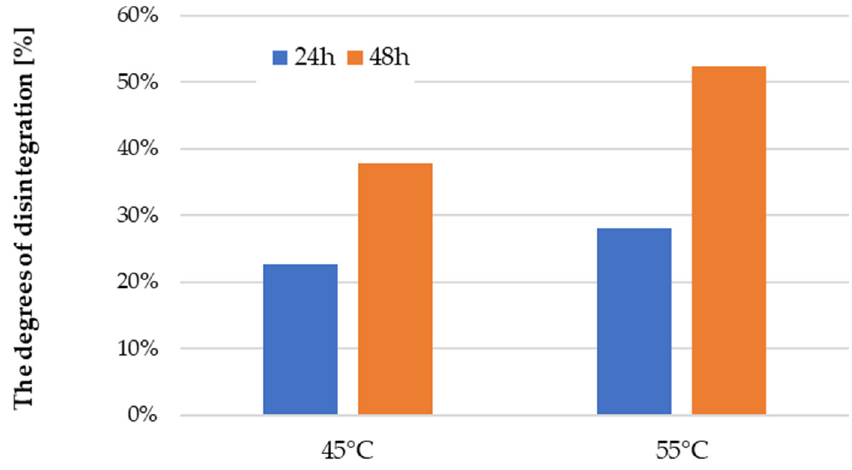
Figure 4. The degrees of disintegration (DD) obtained for various process conditions.